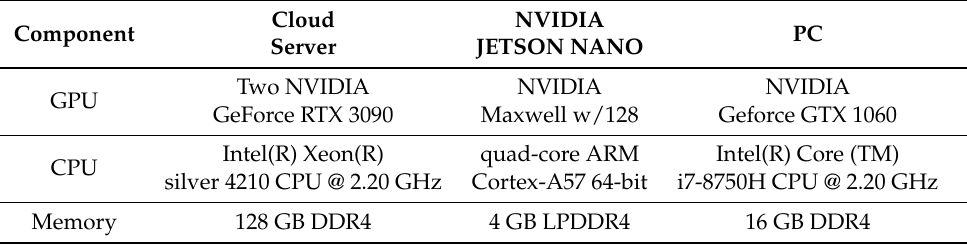
Table 1. Details of hardware resource